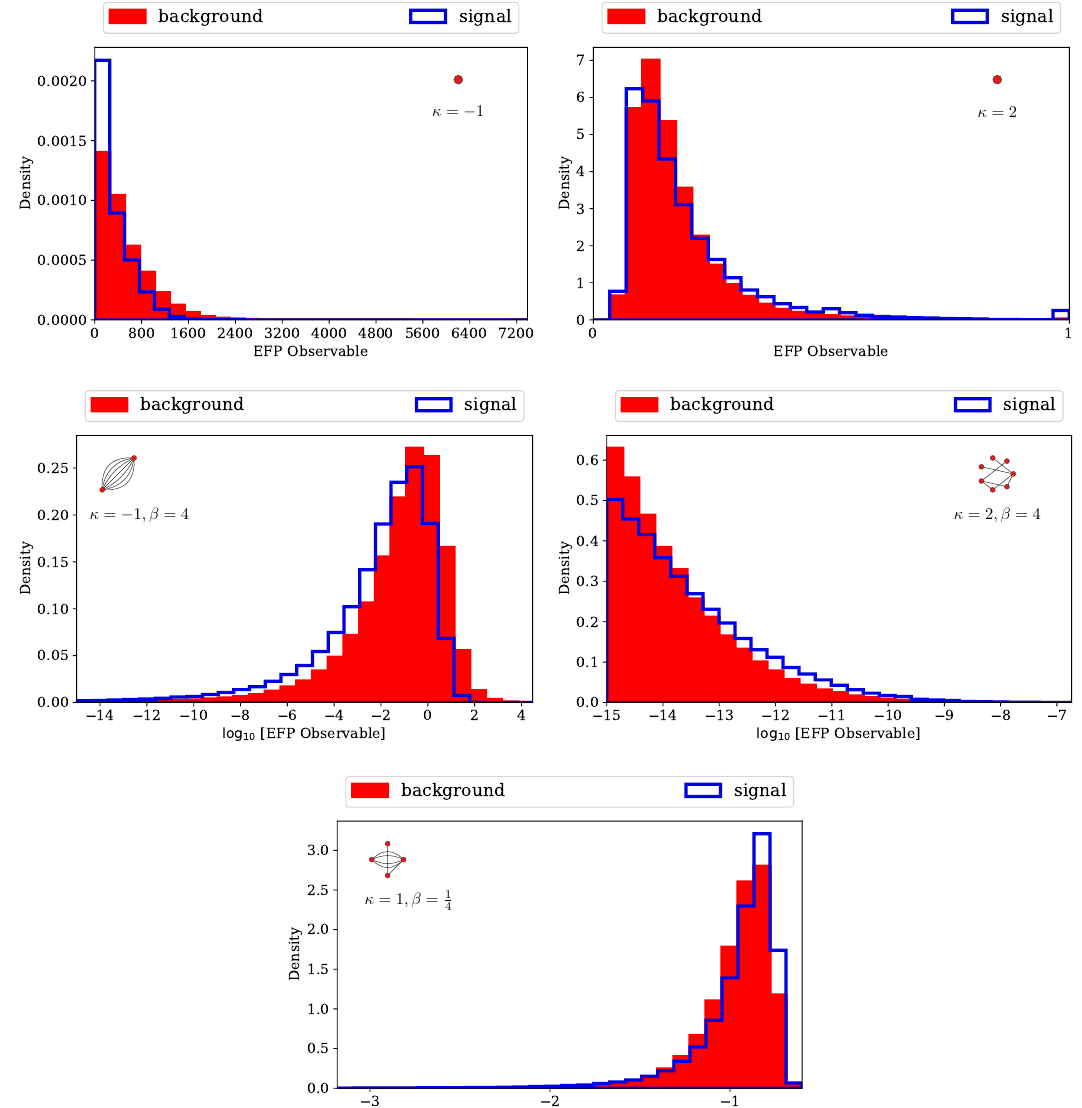
Figure 6. Distributions of the log of the selected EFPs as chosen by the black-box guided strategy, 10 for prompt (signal) muons and non-prompt (background)